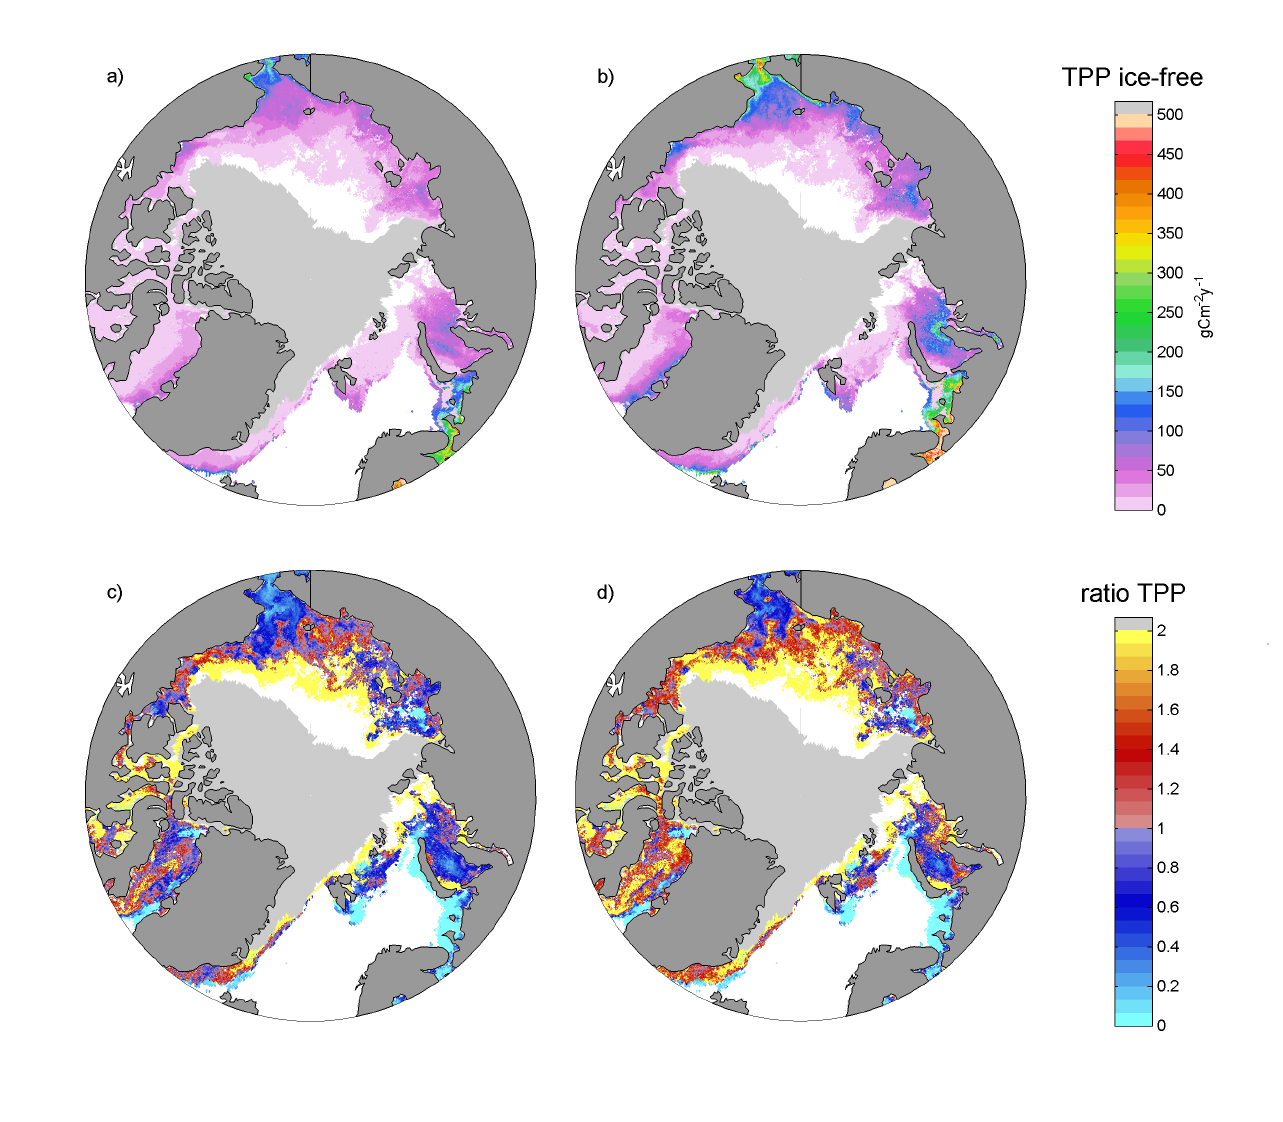
Fig. A1. Alternative algorithms for estimating Arctic primary production. Panels (a) and (b) show total vertically-integrated primary production for the seasonal ice zone for the full year for the Carr (2002) and Marra et al. (2003) algorithms respectively. Panels (c) and (d) show the corresponding ratios of average production rate in MIZ period to that for the rest of the ice-free period. In these latter panels, warmer colours (red-yellow) indicate regions where the MIZ exhibits higher rates of productivity than the rest of the year. In all panels, the land mask is shown in dark grey, light grey areas correspond to permanent sea-ice cover, and white areas to open ocean or missing